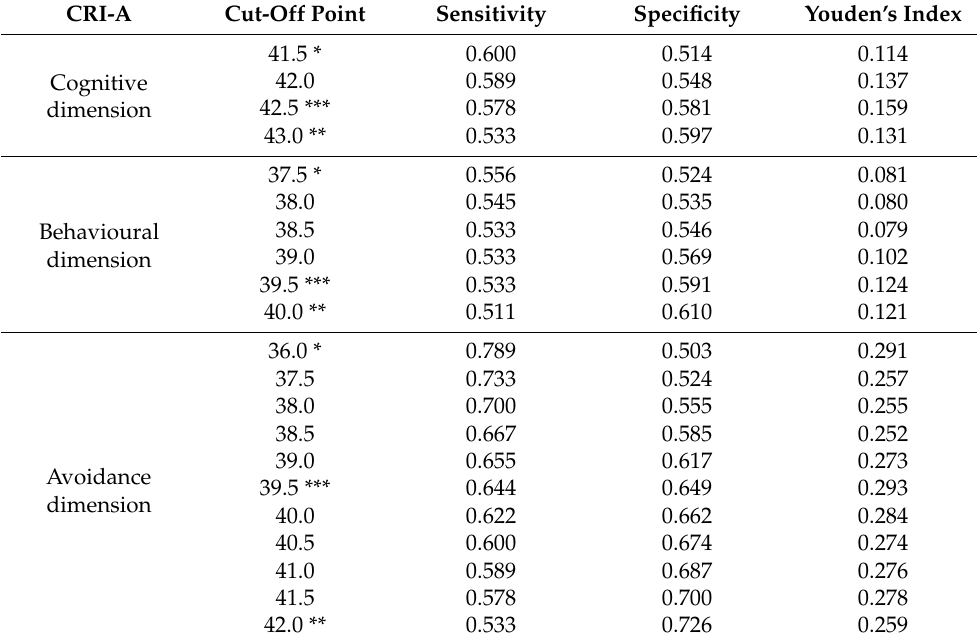
Table 5. Sensitivity, specificity and Youden’s index for scores in the cognitive, behavioural and avoidance dimensions of the CRI-A to identify the presence of psychopathological disorders. CRI-A Cut-Off Point Sensitivity Specificity Cognitive